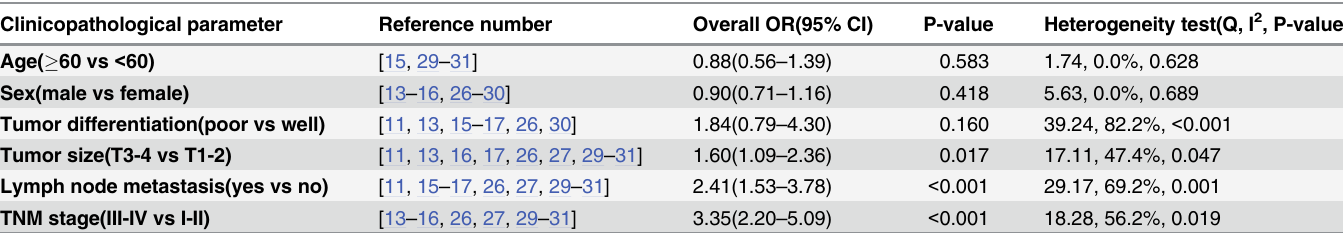
Table 5. Meta-analysis results of the associations of decreased LKB1 expression with clinicopathological parameters. Clinicopathological parameter